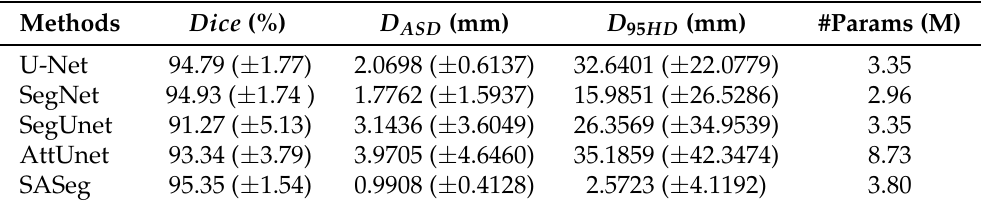
Table 1. Quantitative comparison of segmentation performance in the CBCT dataset between the proposed SASeg and the state-of-the-art